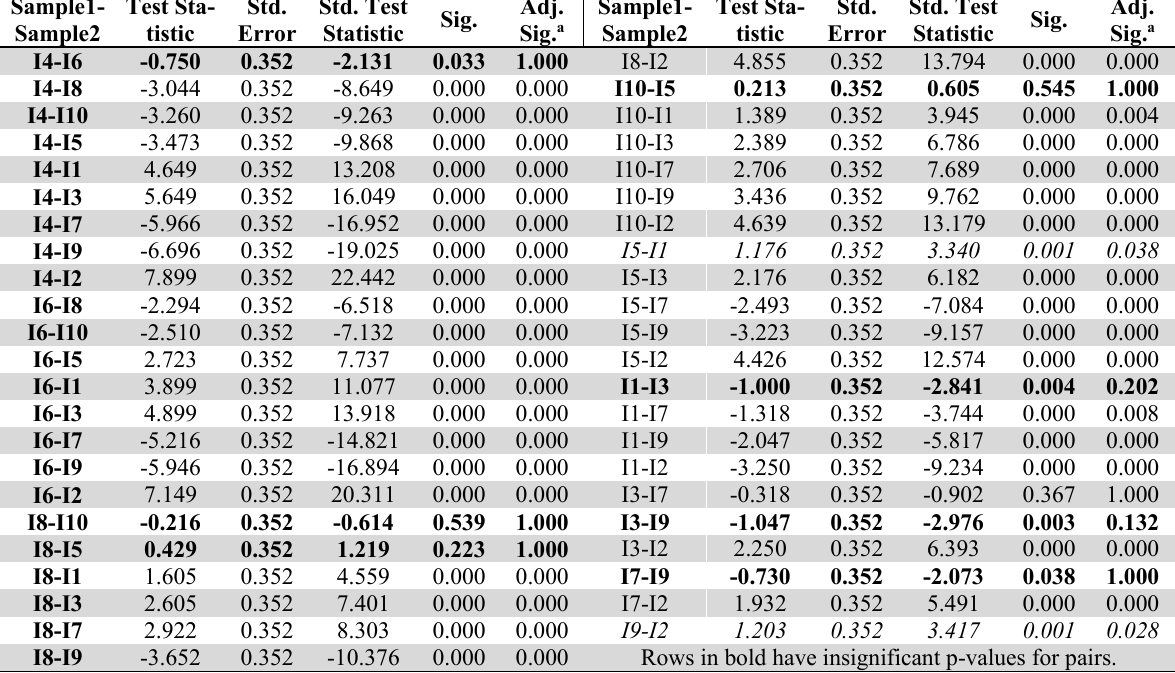
Bonferroni Dunn’s post hoc- Level of importance towards the future plans and strategies